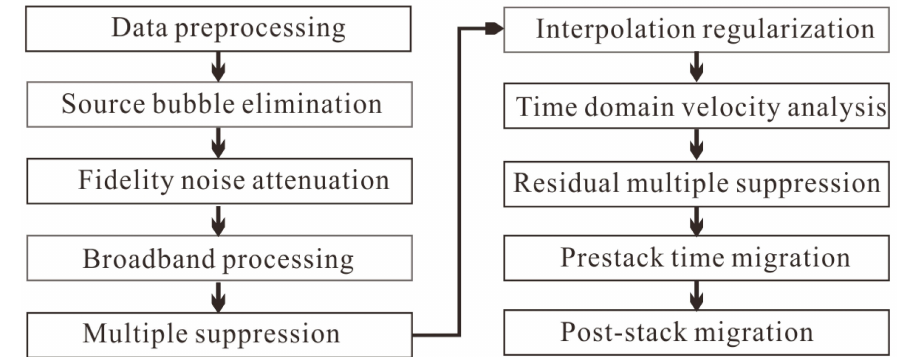
Figure 5. Quasi-3D seismic data processing flow.